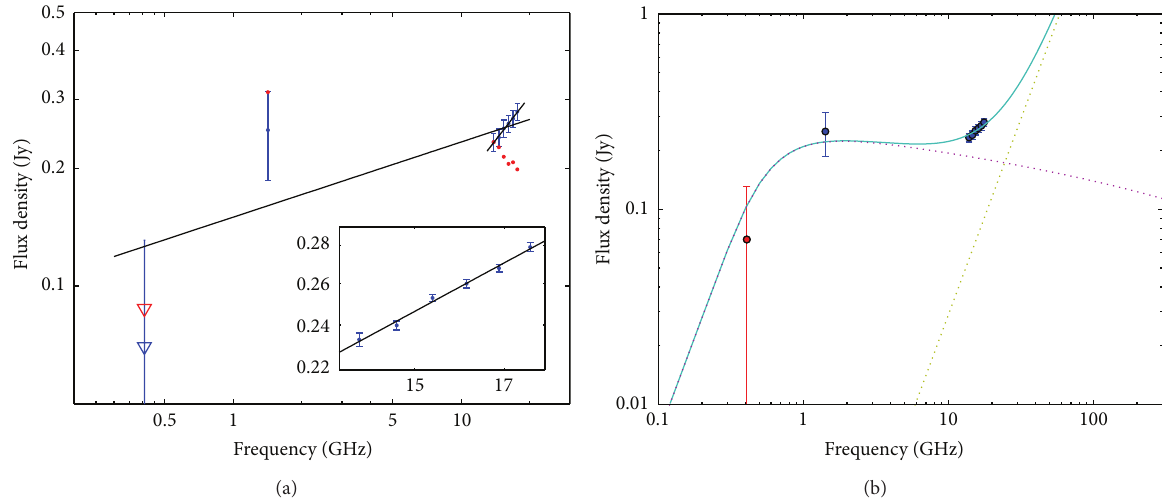
Figure4:SEDforAME-G107.1+5.2.(a)showsthefluxesat0.408and1.42 GHzfromtheCGPSEcataloguenormalisedbythefluxlossexpected in AMI channel 3 and the flux-loss-corrected AMI fluxes. The markers and spectral index fits shown are in Figure 2. (b) shows a fit to the flux densities using a two-component model consisting of a classical and a hypercompact HII region.